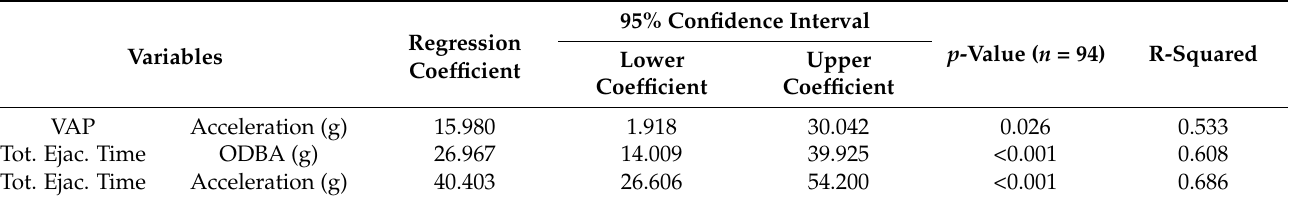
Table 2. Correlations that were significant at p < 0.05 between sperm variables, processing of ejaculation and accelerometer sensor